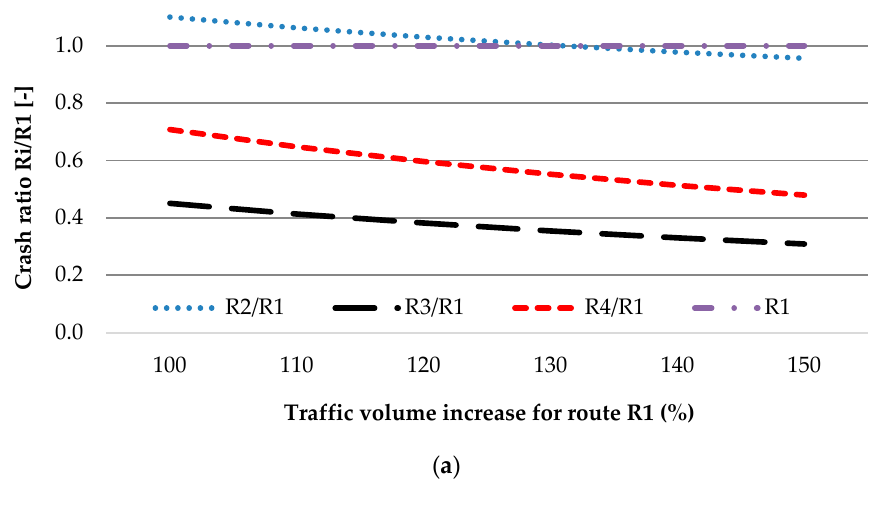
Figure 9. Impact of traffic volume increase for all routes on crashes. The best alternative for the main route R1 is route R3, mainly due to road safety matters. It results in a lower value of AADT (max AADT for R3 is equal to 8954 veh/day) and greater reserves of capacity. An increase in the number of crashes for R3 is lower compared with the main route R1 and is equal to 80% when considering the same percentage increase in traffic volume. In other words, it is possible to reroute 20% more vehicles to route R3 than to main route R1 to obtain the same road safety level. Therefore, it is possible to reroute more traffic in the system to R3. Travel time in peak traffic is also competitive despite the longer routes. One of the main problems in the evaluation of the TTIS performance is related to driver choices or, in other words, how drivers use information from VMSs to select routes. Data about the variability of traffic (Figure 6) allows us to compare data on traffic distribution for one year. The peak period in the year is related to the activities of the region, whose function is mainly recreation. Based on those data (for August), the authors assume that differences in the main route R1 are the result of rerouting caused by the TTIS (higher AADT for R3 and R4). The same data indicate that, during wintertime (January and February), drivers prefer to use national roads (R1 and R2). It can be related to geometrical parameters (lower for regional roads) and the winter maintenance standard of roads (better for national roads). 6. Conclusions The goal of the research was to develop a methodology for the evaluation of the effects on safety and travel time of the rural Travel Time Information System. For this purpose, a flexible approach